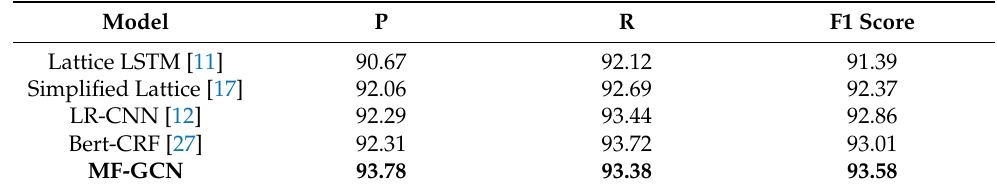
Table 1. Comparison of the effect of different models on the event argument entity recognition of the mechanical fault detection dataset (unit:%).